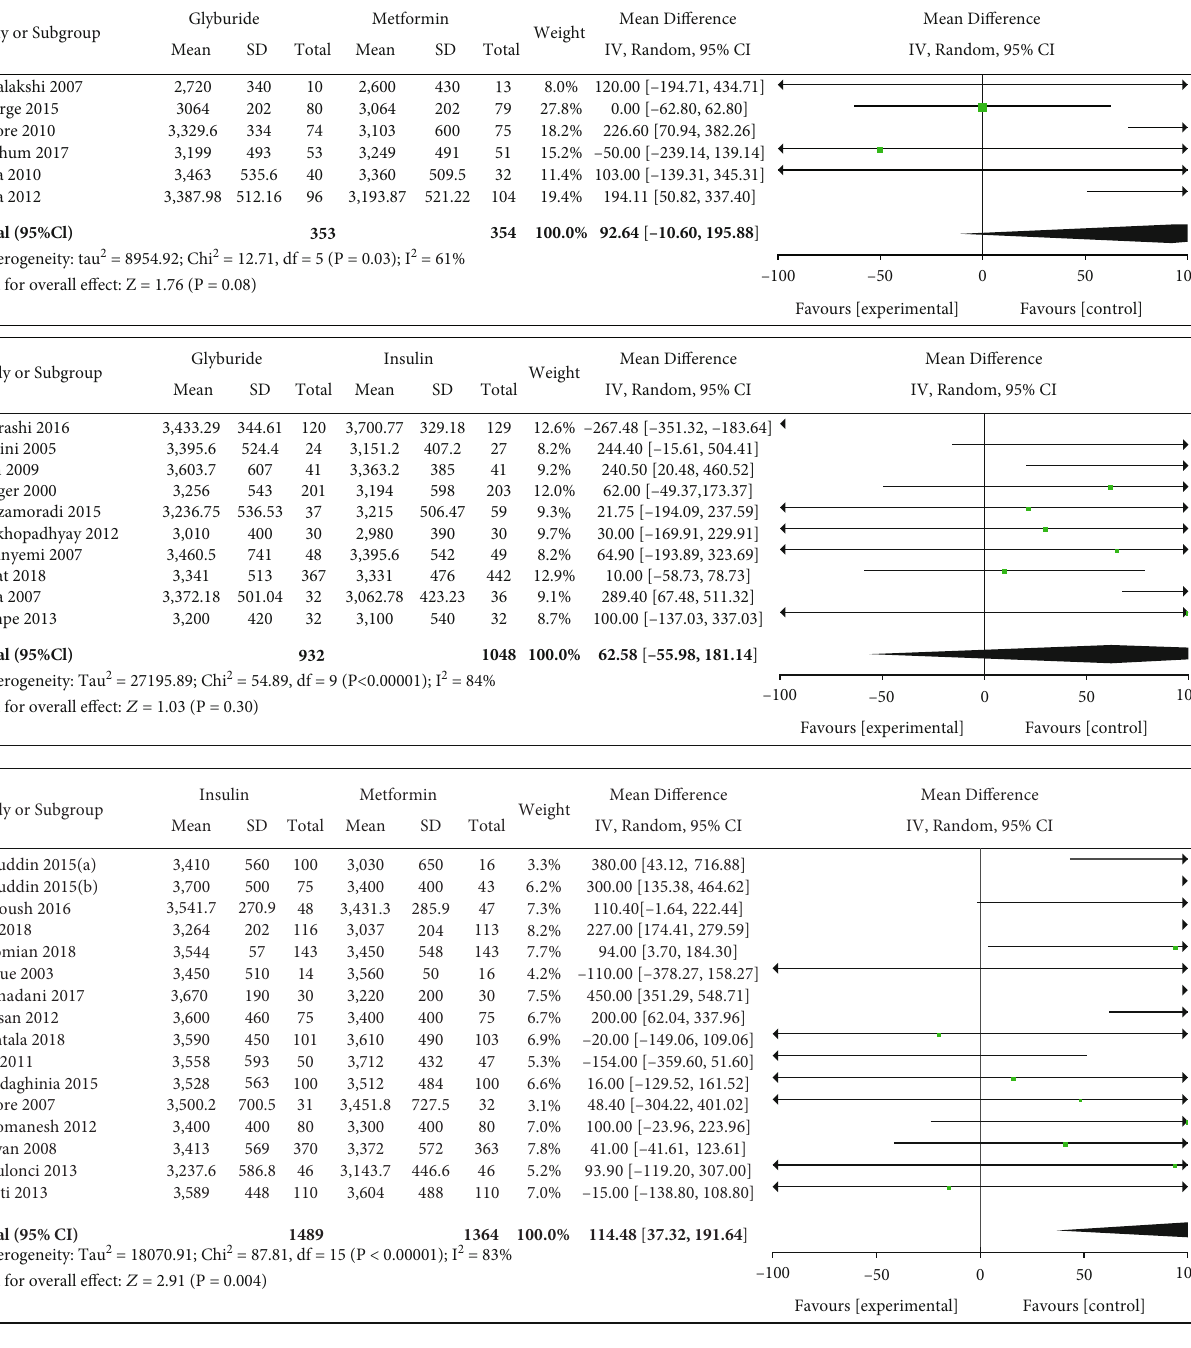
Figure 11: Birth